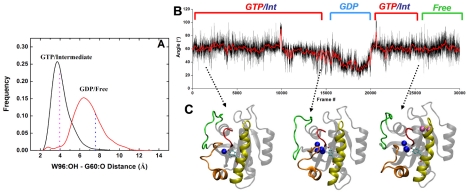
The role of Y96 in a proposed water-mediated allostery.(A) Histogram of the Y96:OH-G60:O distance in the unrestrained simulations plotted separately for conformers having d (see Fig. 4) less than (black) and greater than or equal to (red) 7.5 Å. Vertical dashed lines indicate the corresponding values averaged over the GTP- (left) and GDP-bound (right) x-ray structures. (B) Evolution of the angle between vectors connecting Cα atoms of S89 and Y96, and Cγ and OH of Y96 in the concatenated unrestrained simulations. (C) Representative snapshots highlighting conformers in the GTP, GDP and nucleotide-free states.